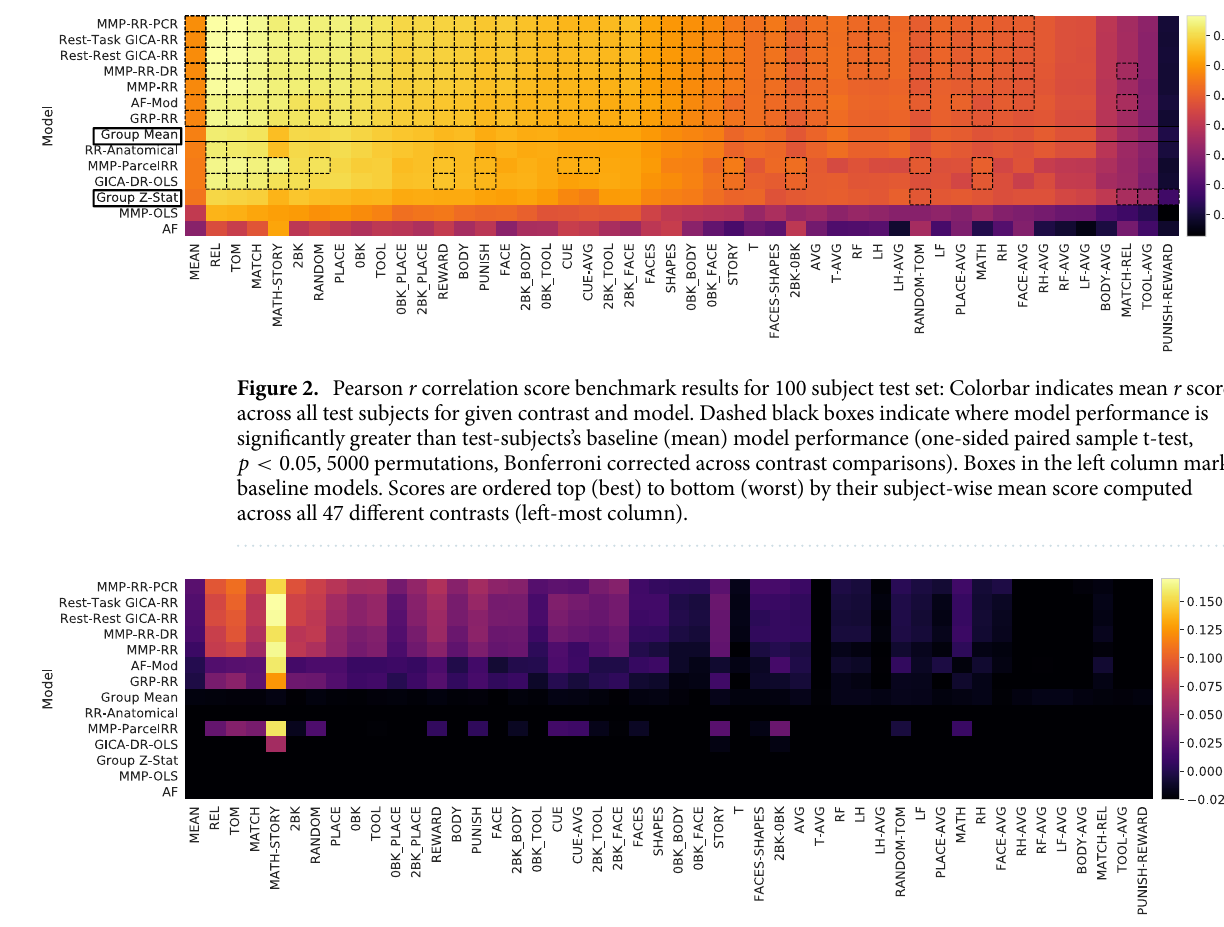
2 2 Figure 3. Predictive R score benchmark results: scores indicate the mean of cortical surface R , see Eq. (1), weighted by the variance of each surface vertex. The colorbar indicates this measure. Roughly half of contrast 2 2 targets have mean cortical R below 0 since predictive R can be arbitrarily negative. Math-Story stands out as the easiest contrast to predict. A discussion providing a reason why is provided in “Spatially resolved predictability” section. Column and row ordering are not sorted by performance and remains identical to Fig. 2. The left most column is the mean score across all